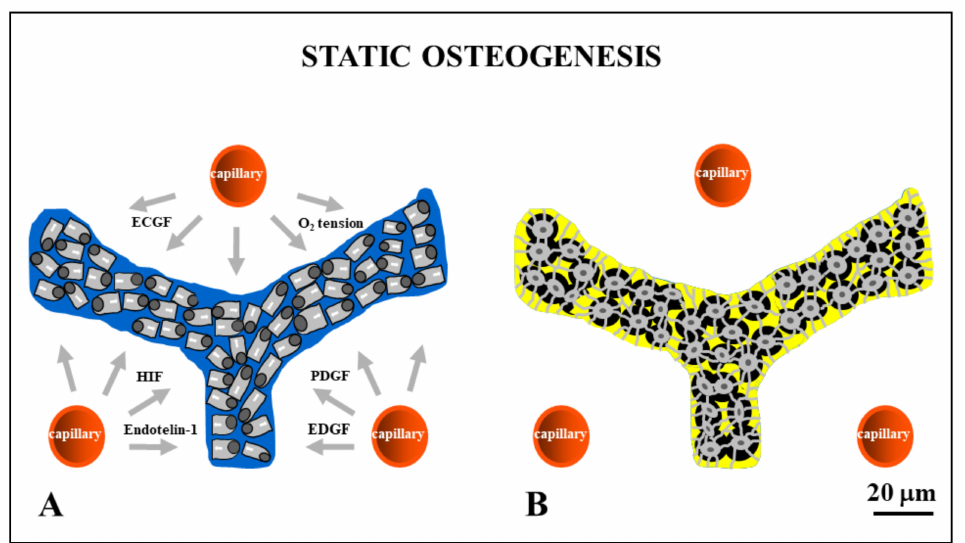
Figure 3. Drawings showing stationary osteoblasts, irregularly arranged in cords, that differentiate among the vessels (red circles). Inside the cords, osteoblasts are polarized in different directions with respect to the adjacent ones ( A ) and give rise to osteocytes ( B ) at the same site where they previously differentiated. ECGF: endothelial cell growth factor; HIF: hypoxia-inducible factor; PDGF: platelet-derived growth factor; EDGF: endothelial-derived growth